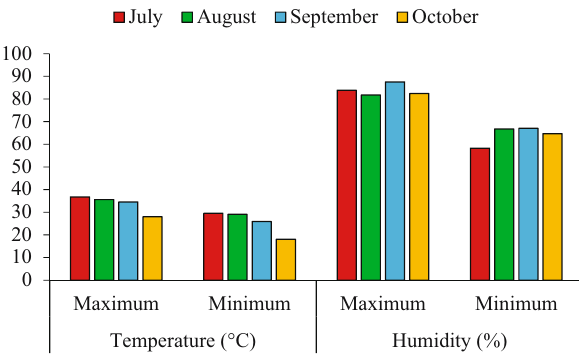
Figure 1: Monthly averages of the meteorological data collected during the